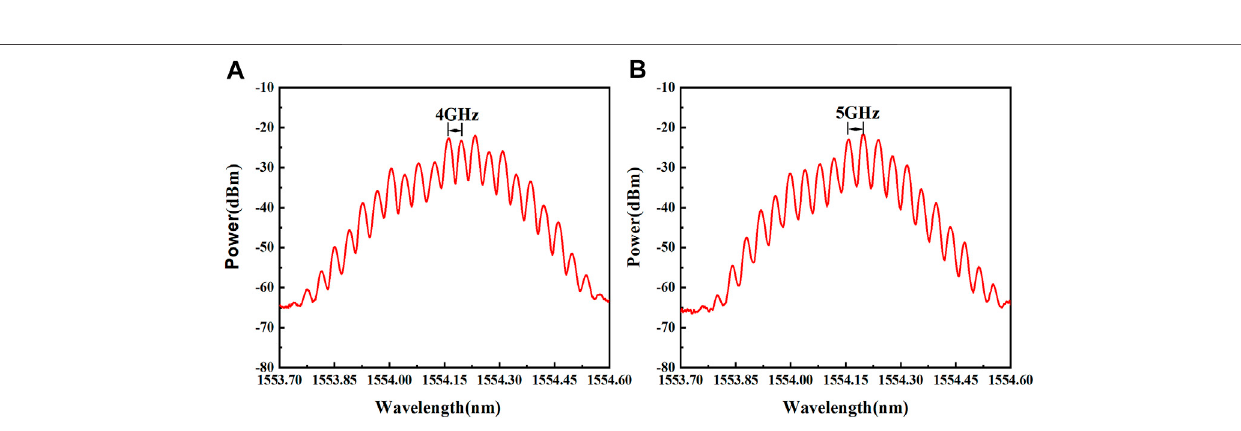
FIGURE 7 | OFCs from the SOA with a comb spacing of (A) 4 GHz and (B) 5 GHz.